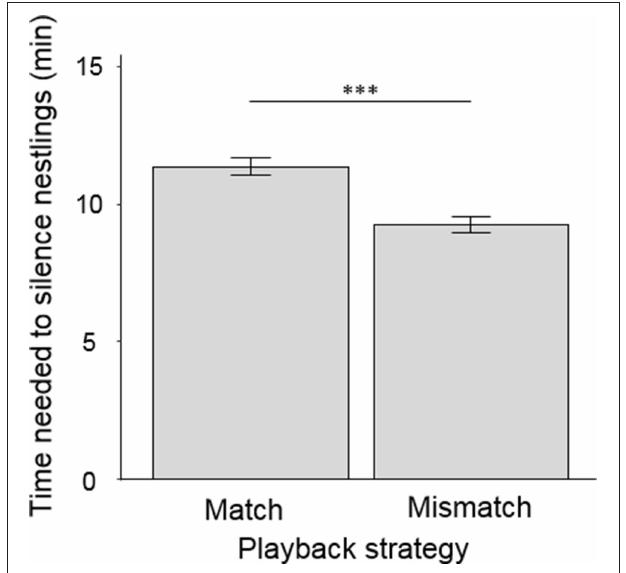
FIGURE 3 | Mean time taken by the playback to silence nestlings depending on the call rate playback strategy (Match vs. Mismatch nestling Call Rate). Only 15-min periods when nestlings stopped calling is included (i.e., N = 63 for Matching and N = 150 for Mismatching strategy). The error bars represent the standard errors. Asterisks indicate significant differences between groups (*** P < 0.001), calculated from the models reported in Table in Supplementary Material S5